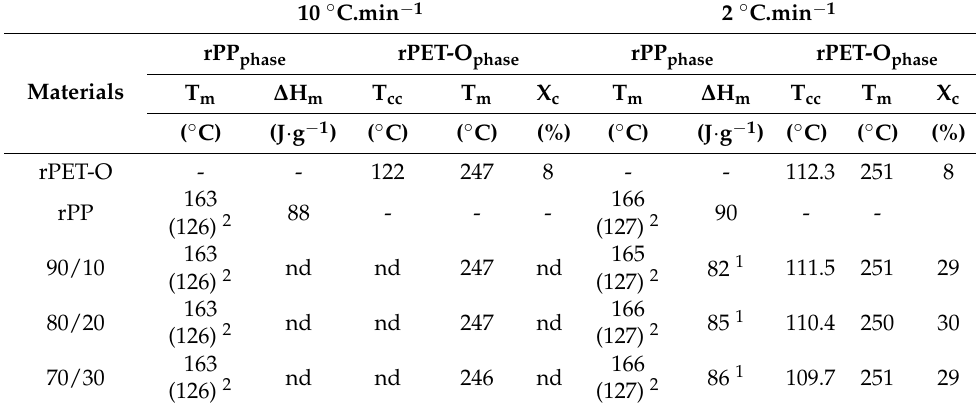
Table 2. Thermal properties of the rPP/rPET-O calendered sheets at two different heating